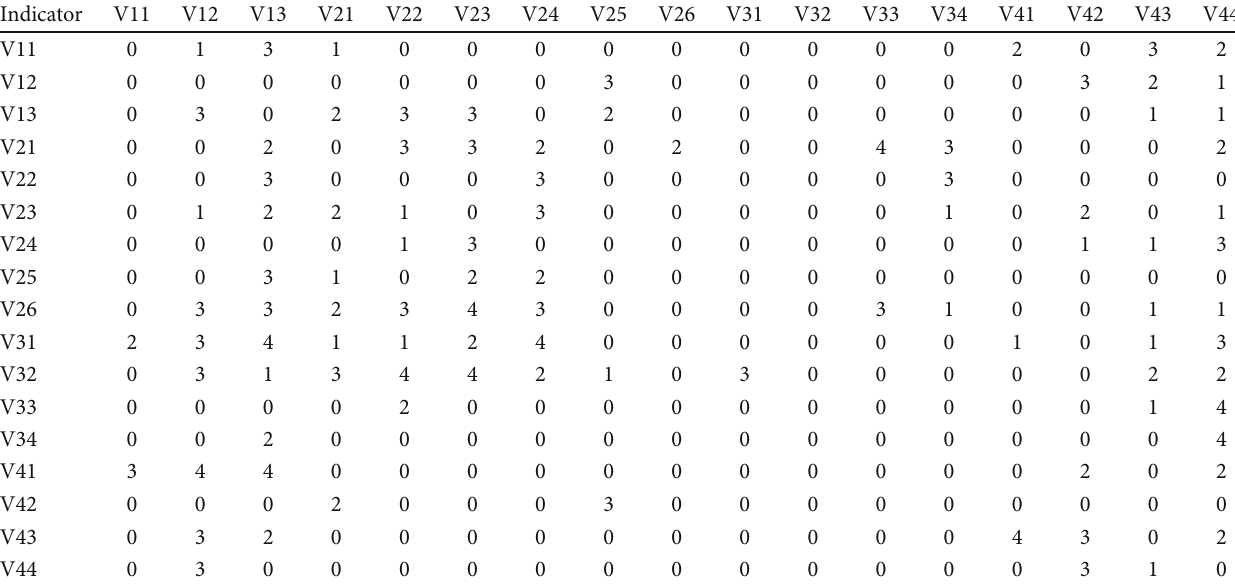
Table 3: The direct in fl uence matrix.